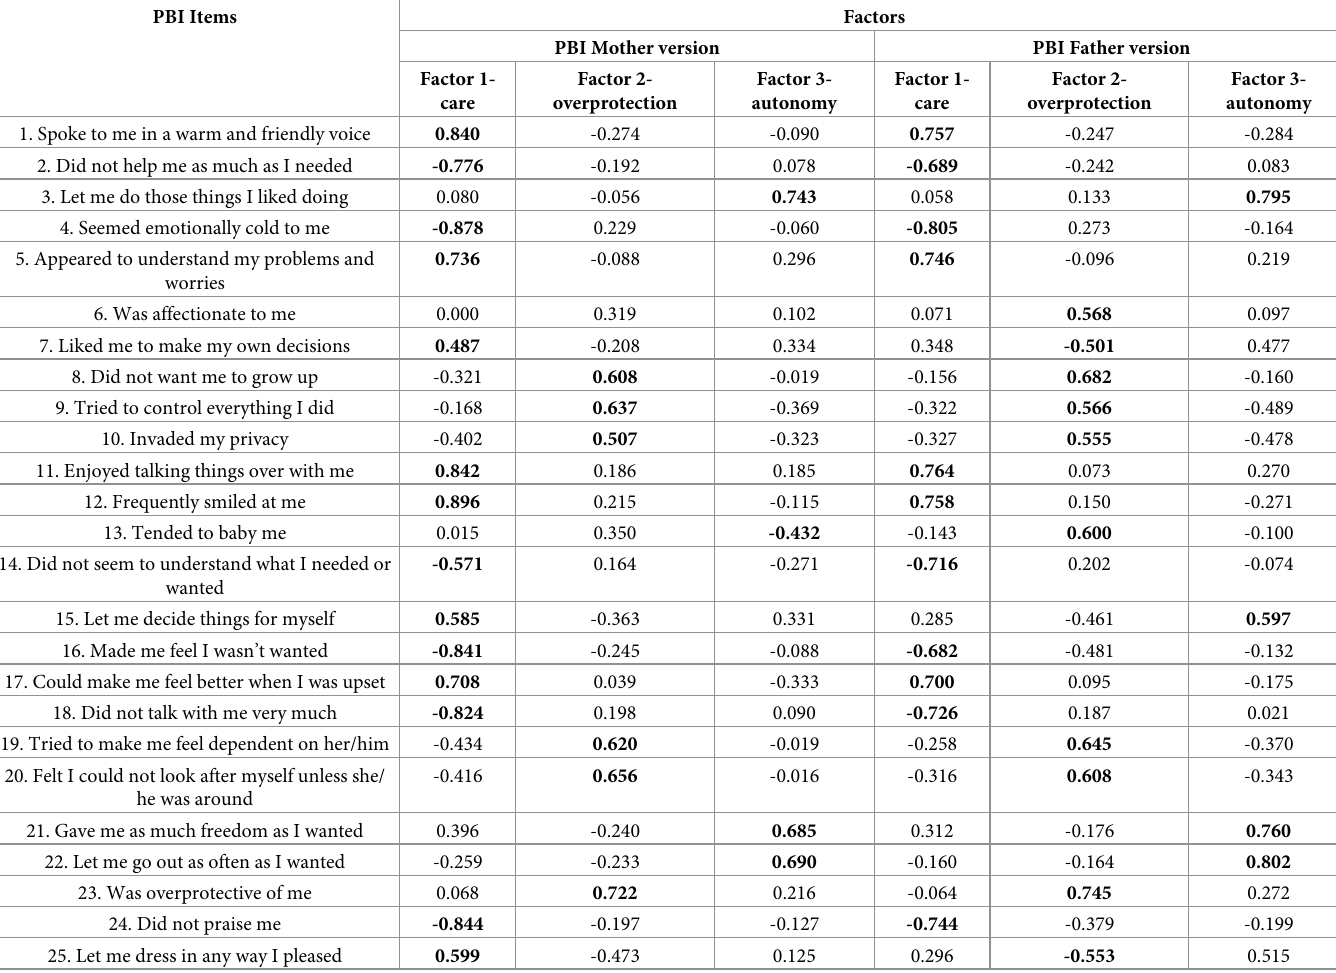
Table 3. Factor loadings of the Polish version of the Parental Bonding Instrument–results of exploratory factor analysis in the group of adolescents (n = 225). PBI Items